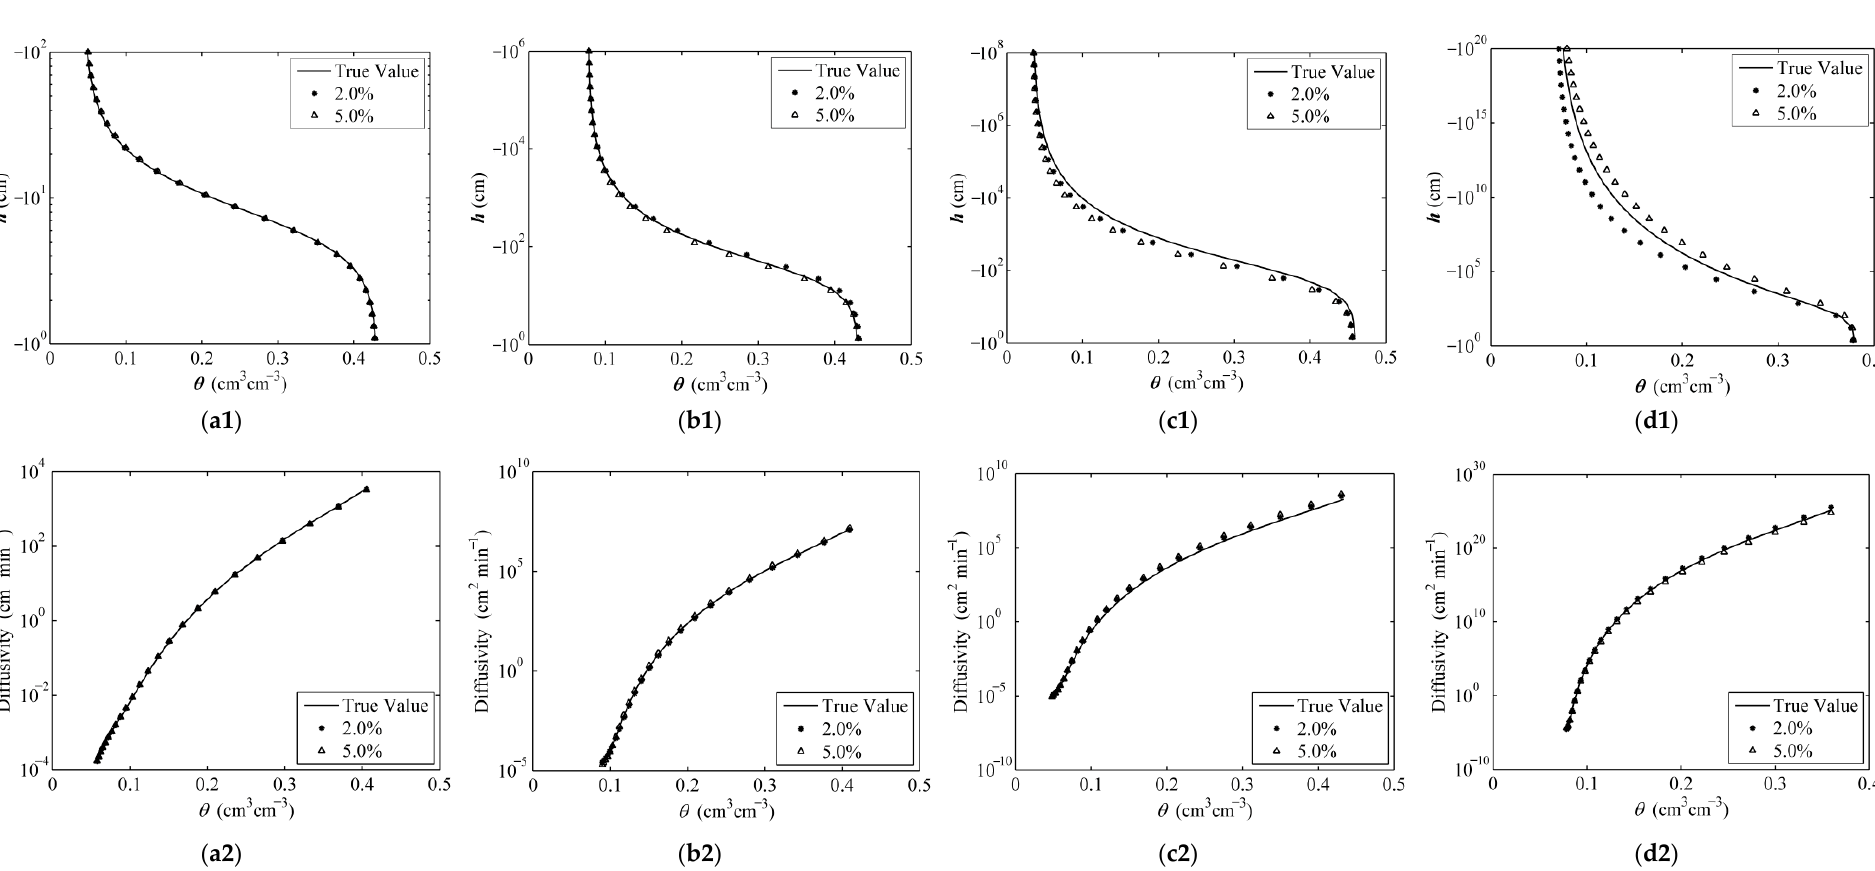
Figure 10. Comparison of SWRCs ( a1 , b1 , c1 , d1 ) and diffusivity curves ( a2 , b2 , c2 , d2 ) with system and random errors for different treatments and calculation using the objective function f ( Q ) (circle: 5.0% random error; triangle: 2.0% system error; square: − 2.0% system error; line: true value): ( a ) sand; ( b ) loam; ( c ); silt, and ( d ) clay.